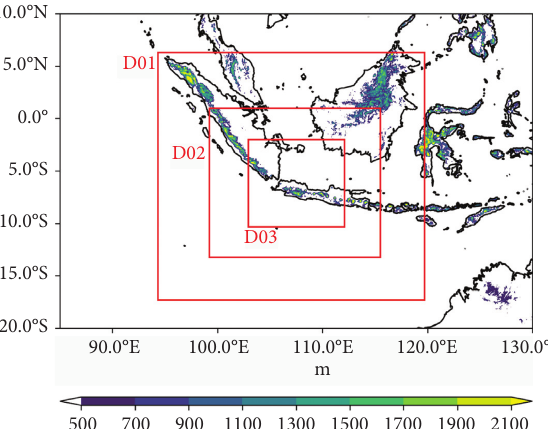
Figure 1: Simulation domain of WRF model. The red boxes represent domains 1, 2, and 3 for 1, 3, and 9km resolution, re- spectively. Colour shaded shows height terrain over